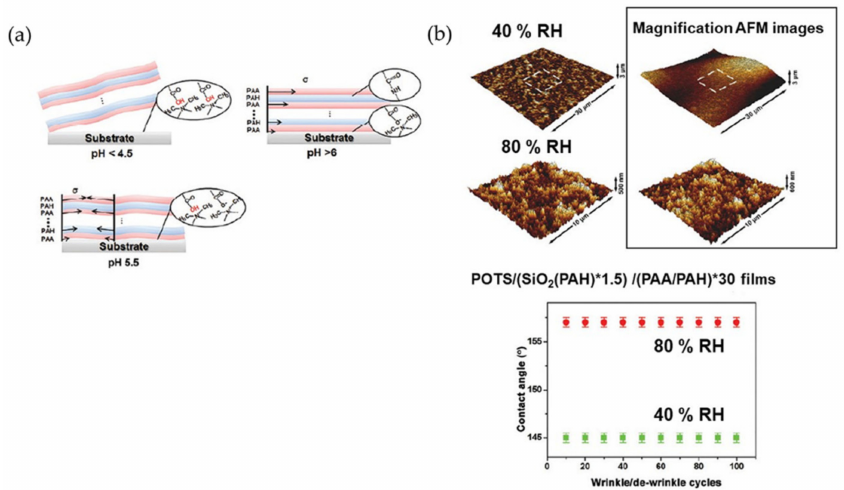
Figure 11. ( a ) Schematic illustration of the interaction of the PAA/PAH films with the PDDA-modified substrate after being immersed in water with different pHs (<4.5; 6> and 5.5.) and ( b ) AFM images and water contact angle changes of the films during repeated de-wrinkle/wrinkle process in 40% RH and 80% RH. Reproduced with permission from reference [57]. Copyright 2016, Springer